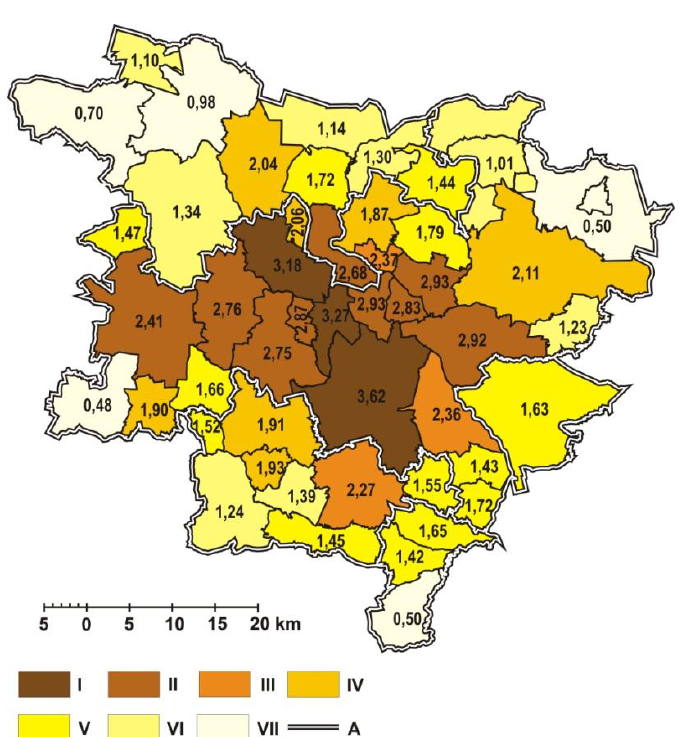
Fig. 5. Accessibility of the public transportation in the communities of the Katowice conurbation (own study) The sum of standardized values of indicators: I – 3.01 and more; II – 2.61 – 3.00; III – 2.21 – 2.60; IV – 1.81 – 2.20;